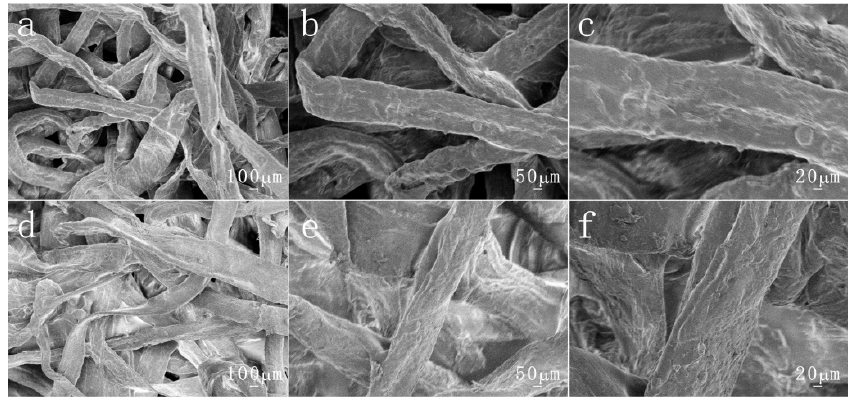
Figure 5. The different magnifications of SEM images by hydrochloric acid-treated (pH = 1) ( a – c ) pristine paper and ( d – f ) the copolymer-coated paper.